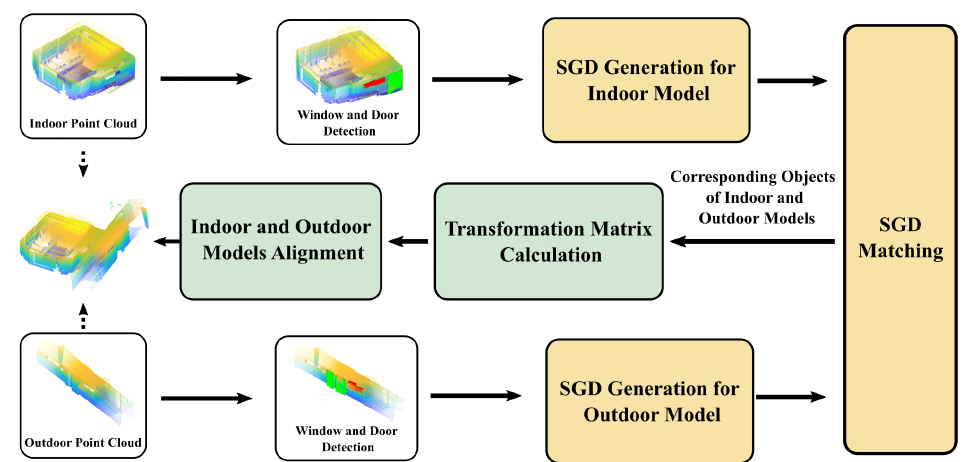
Figure 1. The overview of the proposed method. By matching the SGDs of indoor and outdoor point clouds, the corresponding objects can be recognized and the transformation between indoor and outdoor point clouds can be calculated